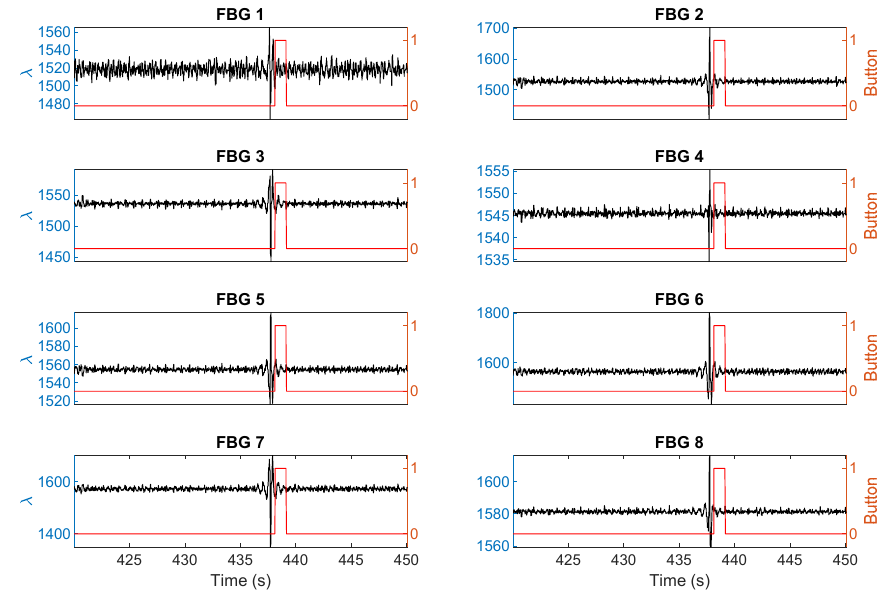
Figure 9. Independent component analysis of the raw sensing signals shown in Figure 8. The black line with the left y axis shows the response of the sensor. The red line with the right y axis shows the mother’s perception.